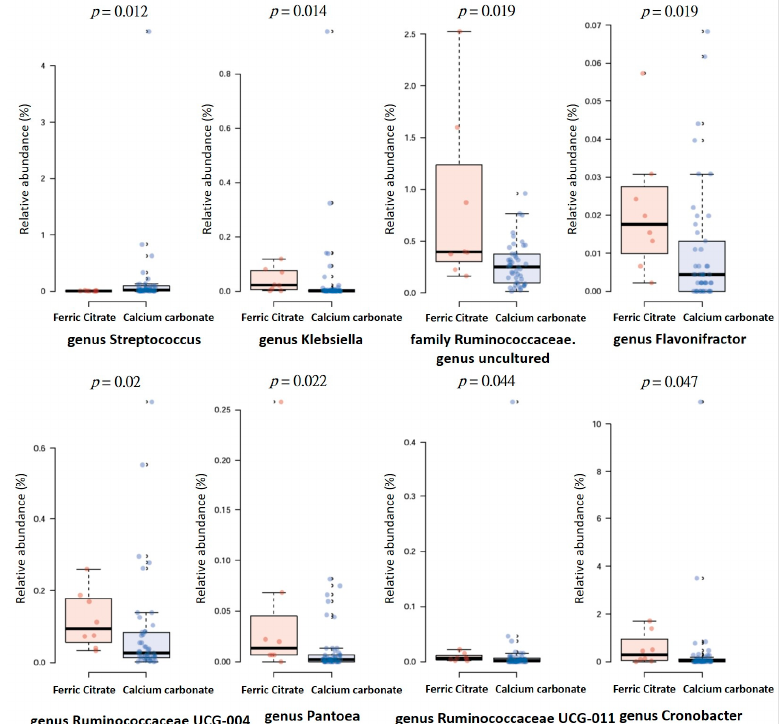
Figure 4. The distribution of top eight genera abundance difference between hemodialysis patients with ferric citrate or calcium carbonate phosphate binders treatment.